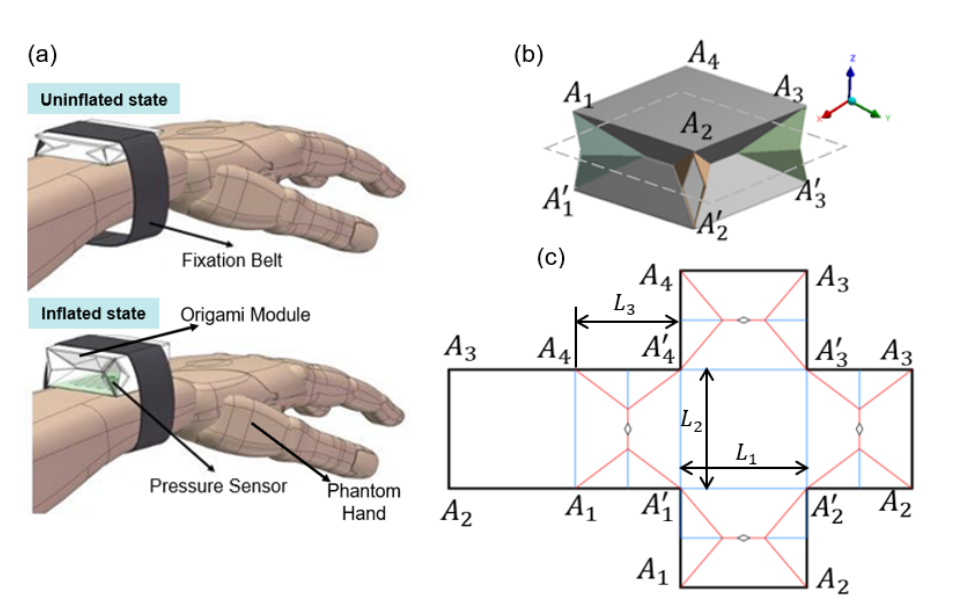
Figure 1. ( a ) The potential application scenarios of the wearable device for multiple DOF force- sensing: the foldable structure can be fixed to the fixed strap for easy wearing on the human wrist. The foldable structure in an uninflated state is easy to wear and can be adjusted to a fixed position on the wrist for wearing comfort; the foldable structure in an inflated state can be fixed on the wrist, and the sensitivity of the sensor can be variable by adjusting the pre-pressure value. ( b ) This core origami model is made of a parallel waterbomb-like unit. Based on the advantages of soft materials, the structure has multiple pseudo-DOFs compared to the rigid ones, allowing for various basic motion modes. ( c ) The folding pattern of this origami structure is shown, where solid red lines represent the mountain folds, and solid blue lines represent the valley folds. The essential size parameters L 1 , L 2 , and L 3 of this structure are designed as 60, 60, and 50 mm respectively. The diamond cutouts release the fixed constraints from the middle creases and stress concentrations from the folding